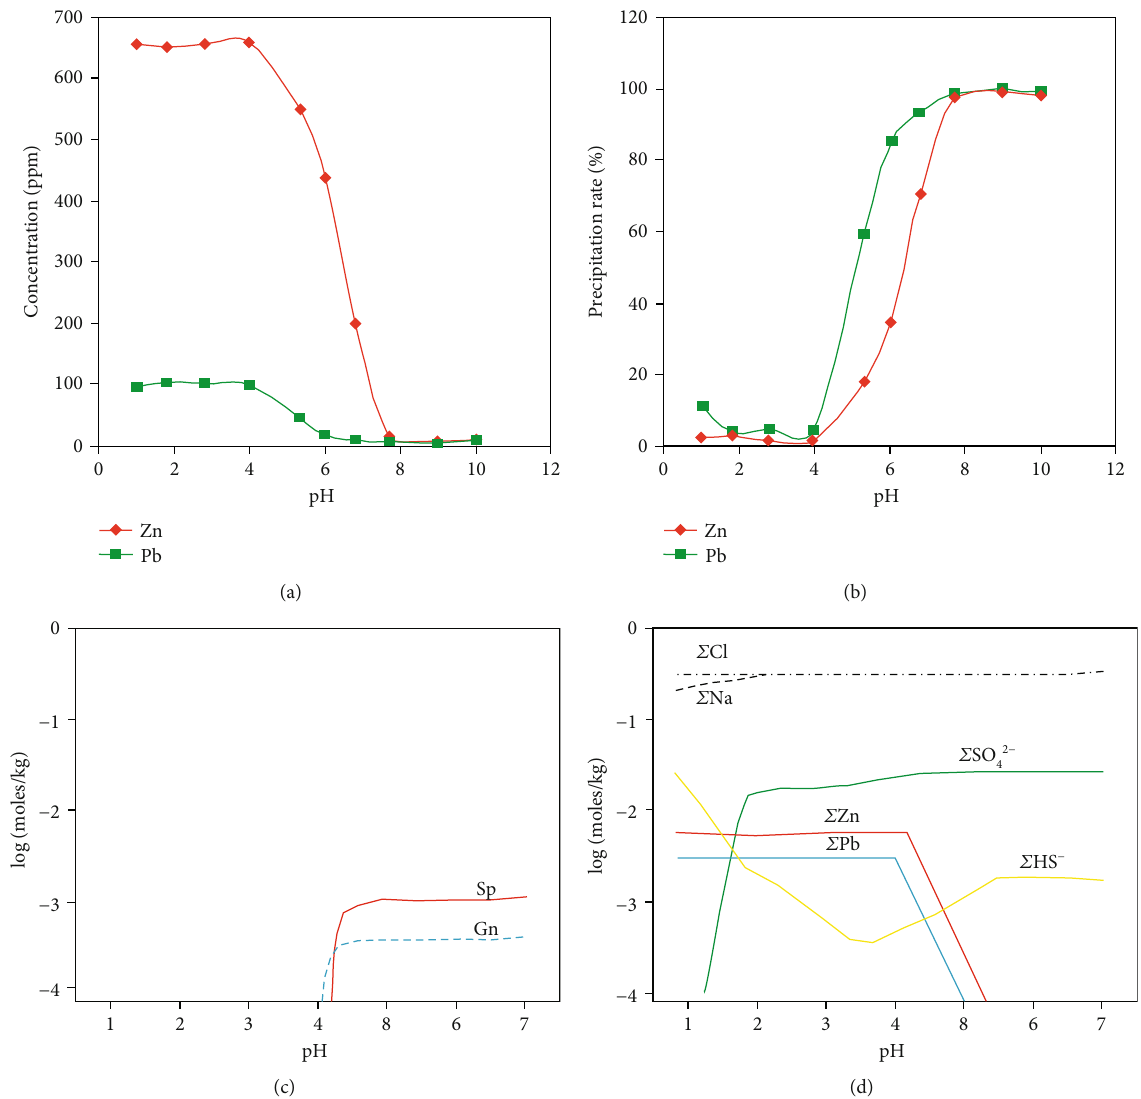
Figure 3: E ff ects of pH changes on Pb – Zn precipitation (c and d according to Reed [40]). (a, b) E ff ects of pH changes on Pb and Zn precipitation when the acidity of mixed solution ② was adjusted. (a) Concentration vs. pH. (b) Precipitation rate vs. pH. (c, d) Computational simulations of the e ff ects of pH changes, where NaOH was added to an acidic fl uid (1 mol NaCl, initially) with aqueous Pb and Zn to increase its pH from 0.8 to 7 at T = 200 ° C . (c) Minerals. (d) Total concentrations of the aqueous